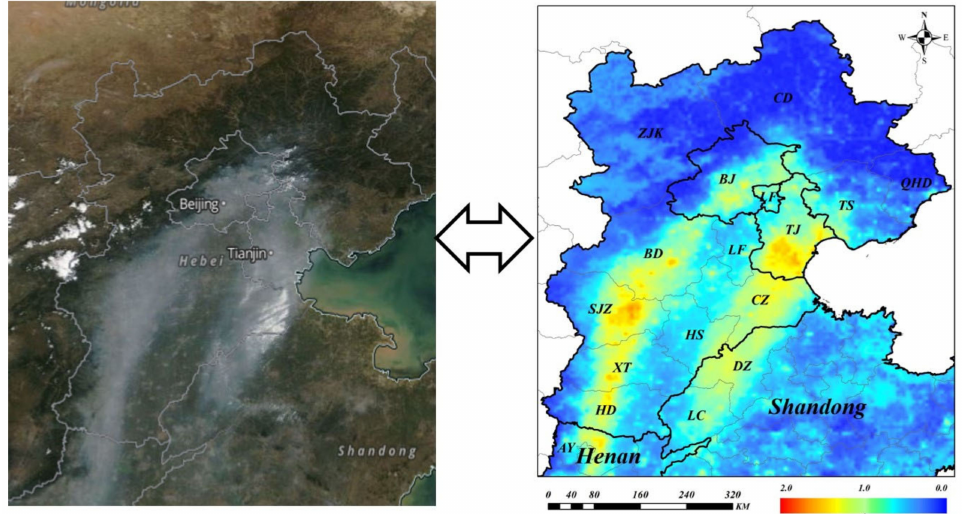
Figure 2. The satellite true color map (MODIS) and the distribution of AOD in the NCP region on 22 September